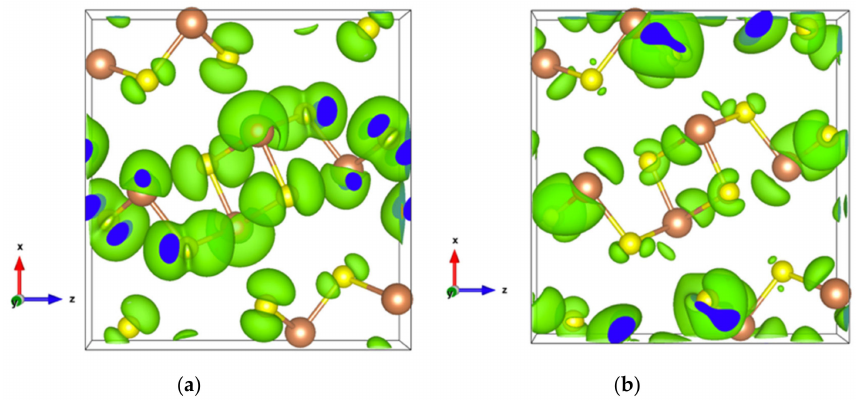
Figure 4. Electronic density of Sb 2 S 3 with an isosurface of 0.0005 electrons / bohr 3 . ( a ) For the highest occupied orbital; ( b ) For the lowest unoccupied